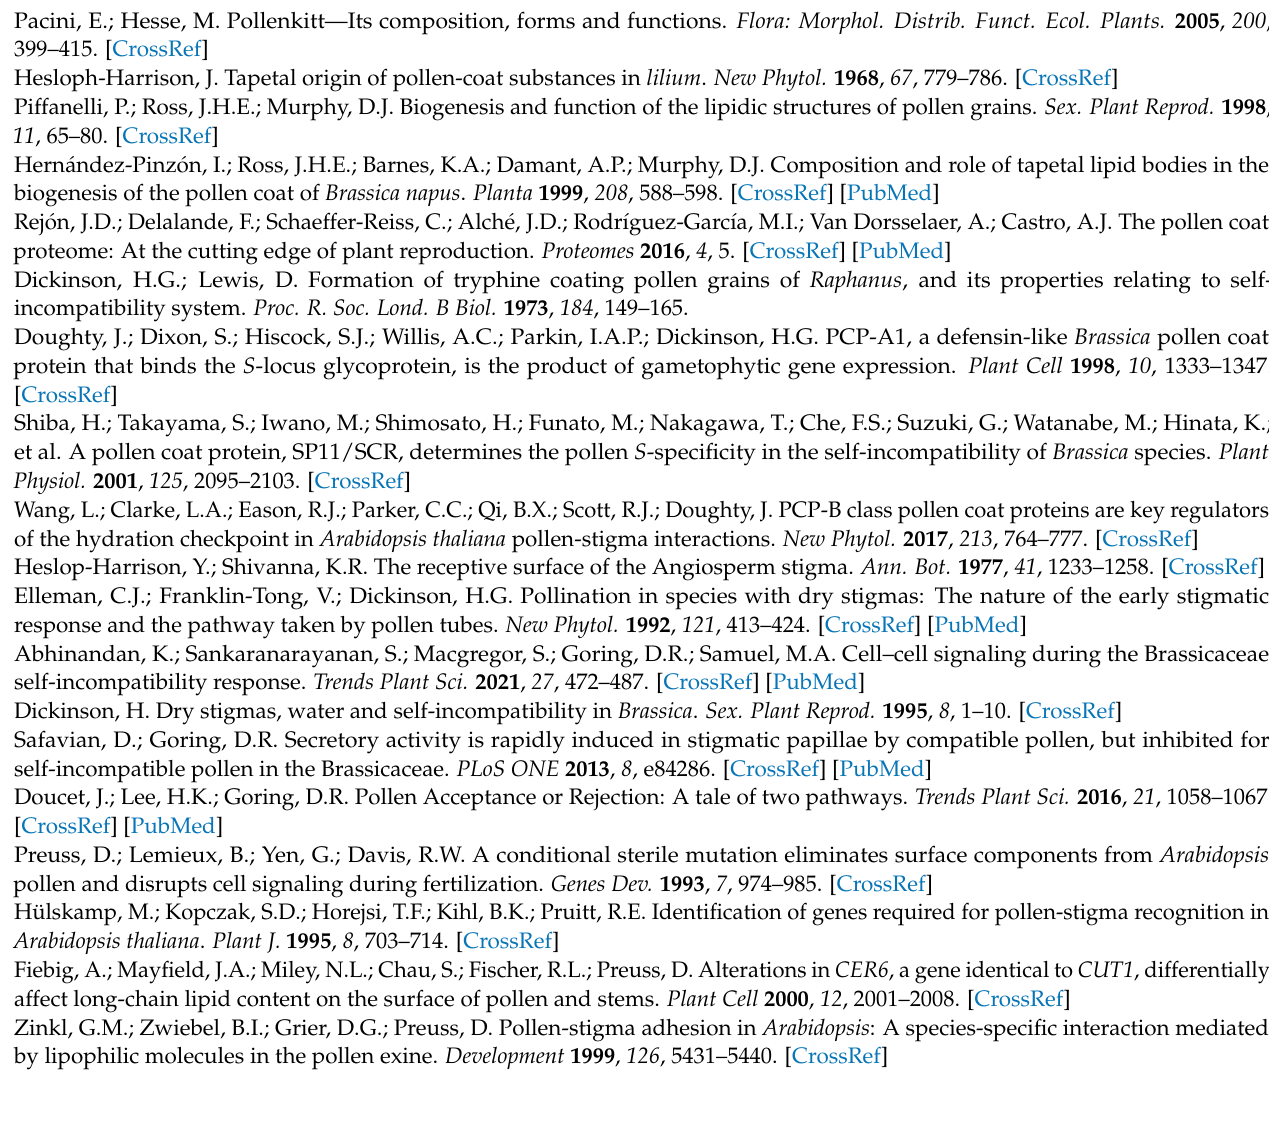
lyrata pollen coat, Table S13: Cysteine-rich proteins (CRPs) detected from the Brassica oleracea pollen coat, Table S14: Lists of Arabidopsis thaliana pollen coat proteins or constituent genes that overlap with previously reported proteomes and